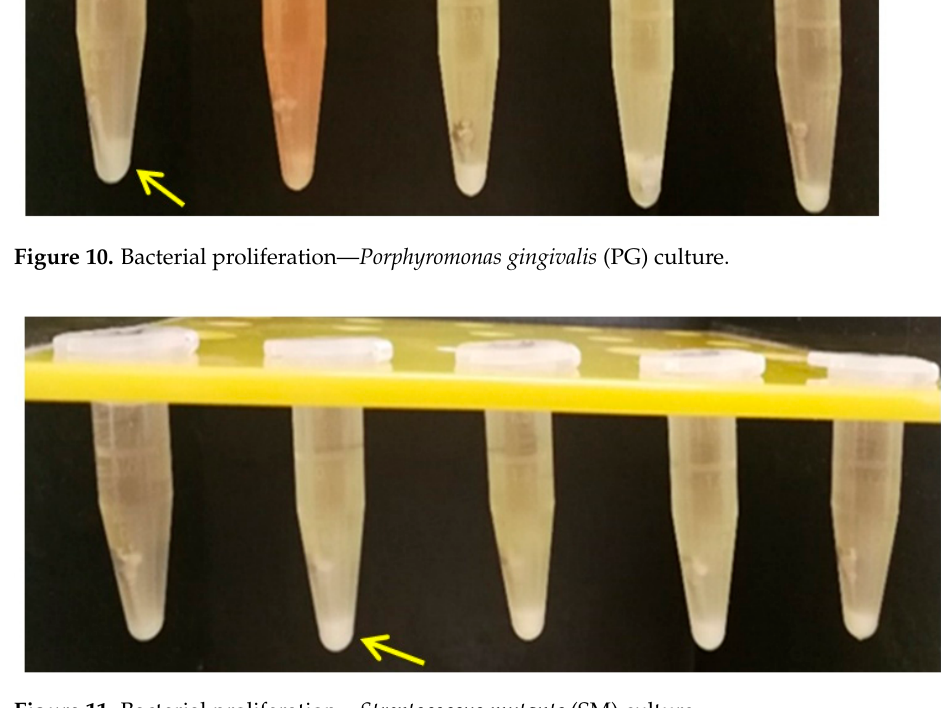
Figure 11. Bacterial proliferation— Streptococcus mutants (SM) culture.